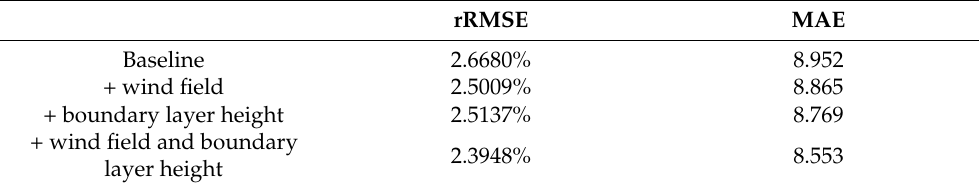
Table 1. Ablation test result.